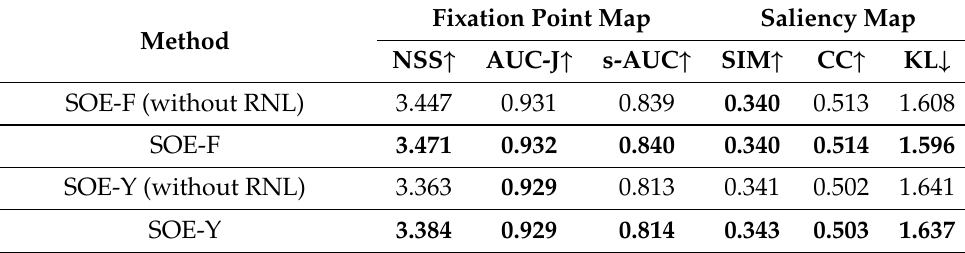
Table 4. Comparison of SOE-F and SOE-Y performance on the DADA-2000 dataset with or without RNL (The symbol ↑ prefers a larger value and ↓ expects a smaller value. Bold indicates the best